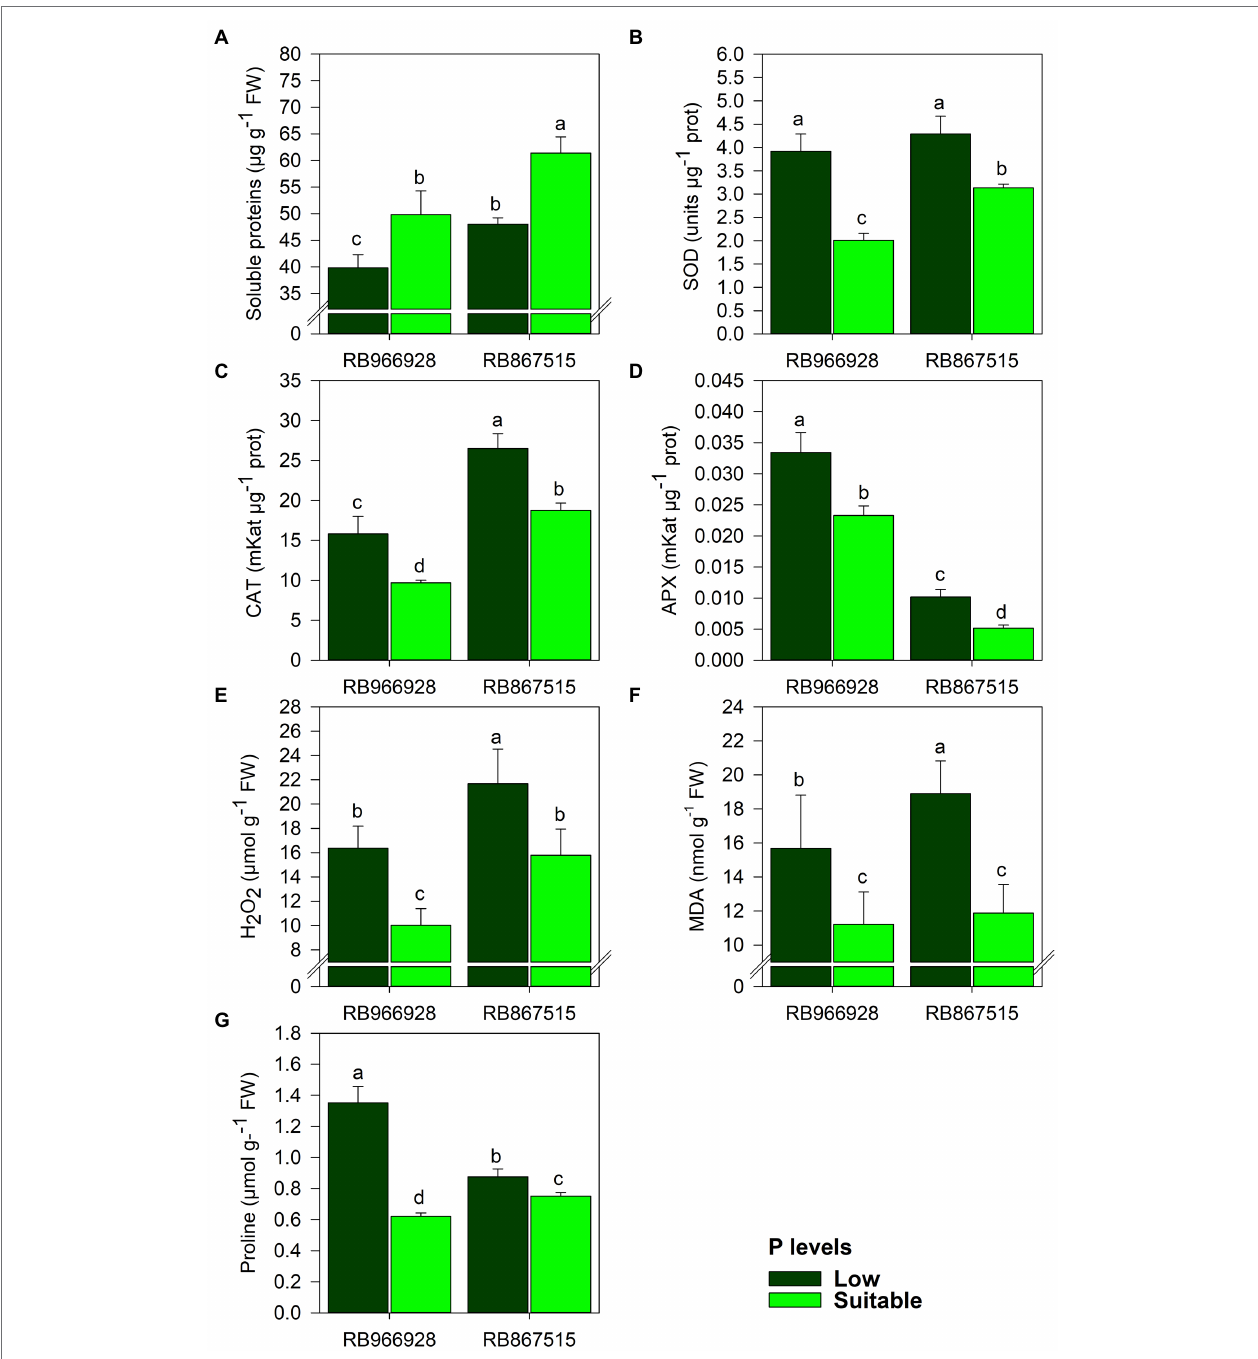
FIGURE 2 | Leaf levels of (A) soluble sugars, (B) superoxide dismutase (SOD) activity, (C) catalase (CAT) activity, (D) ascorbate peroxidase (APX) activity, (E) hydrogen peroxide (H 2 O 2 ), (F) malondialdehyde (MDA), and (G) proline as a function of sugarcane RB966928 and RB867515 varieties and low and suitable P levels. Different letters indicate significant differences between sugarcane variety and P level by Student’s t -test at p ≤ 0.05. The error bars express the SE of the mean ( n =